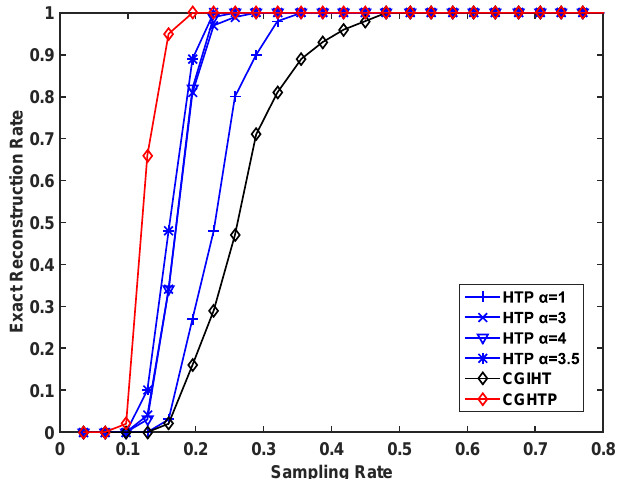
Figure 9. Exact reconstruction rate vs. sampling rate for a Gaussian